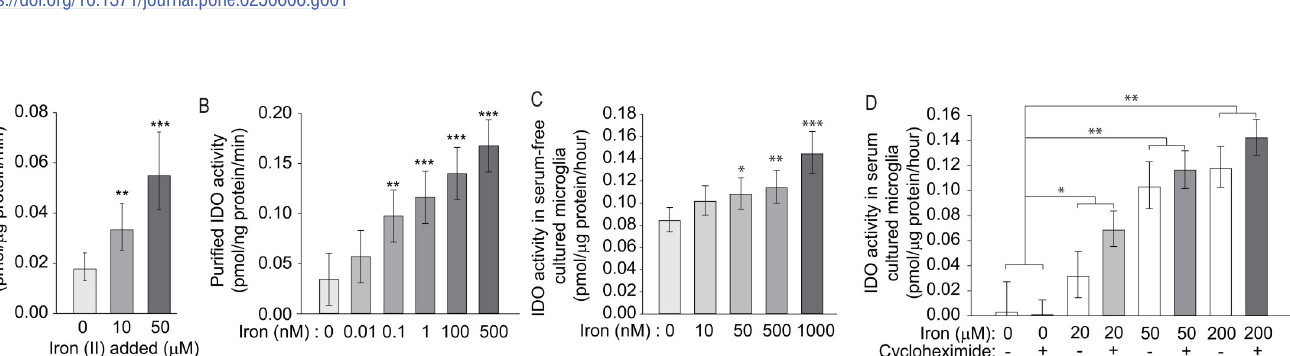
PLOS ONE | https://doi.org/10.1371/journal.pone.0250606 May 14,